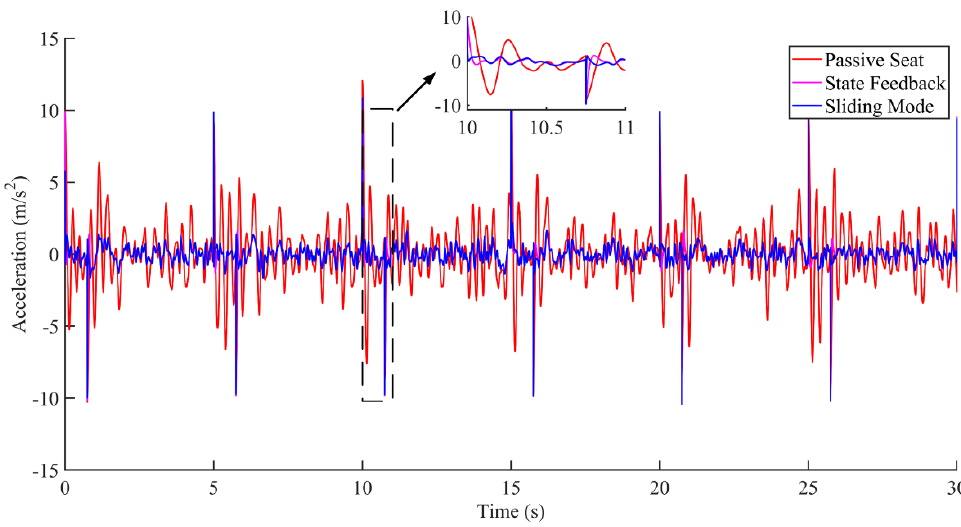
Figure 17. Acceleration comparison under the condition of interference.